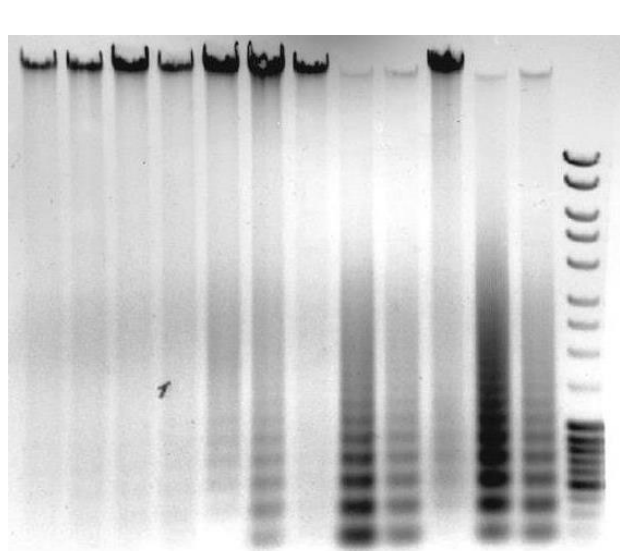
Figure 10. Melanoma cell DNA agarose gel electrophoresis after infection with MV strain L-16. Lines correspond to the following cells: 1—HDF + L-16, 24 h p.i., 2—mel Il + L-16, 24 h p.i., 3—mel Z + L-16,